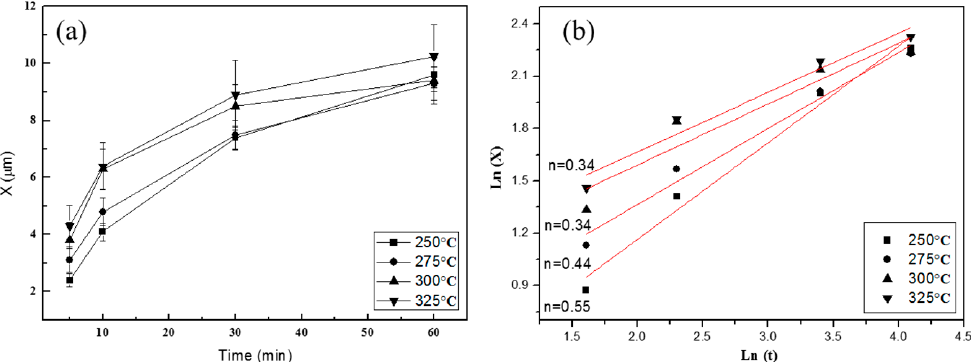
Figure 6. Thickness ( X ) of Sn–Te–Se–Bi phase formed during diffusion soldering of Bi 2 Te 2.55 Se 0.45 thermoelectric material with Cu electrode using Sn interlayers: ( a ) X versus t , ( b ) Ln X versus Ln t .